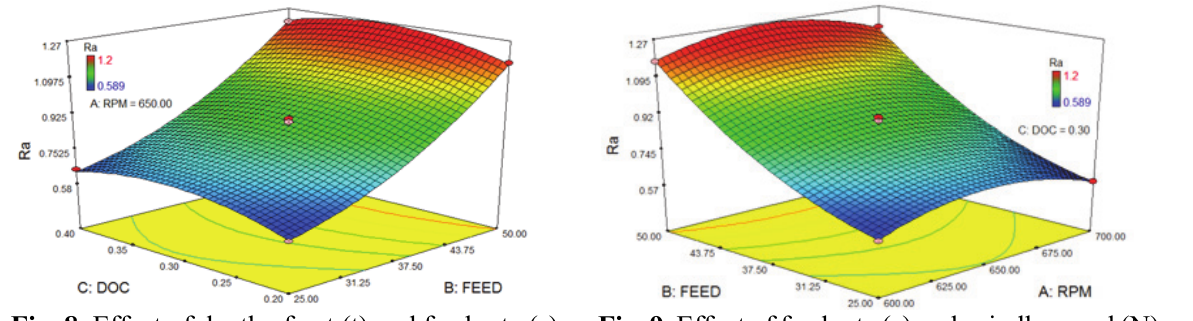
Fig. 8. Effect of depth of cut (t) and feed rate (s) on surface roughness (3-D plot)